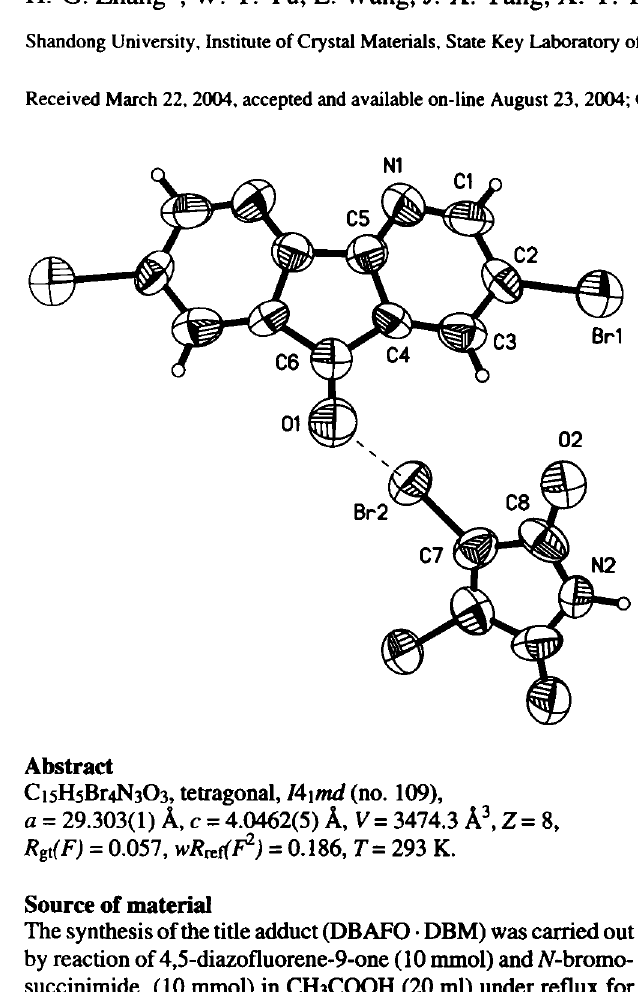
Table 2. Atomic coordinates and displacement parameters (in Â 2